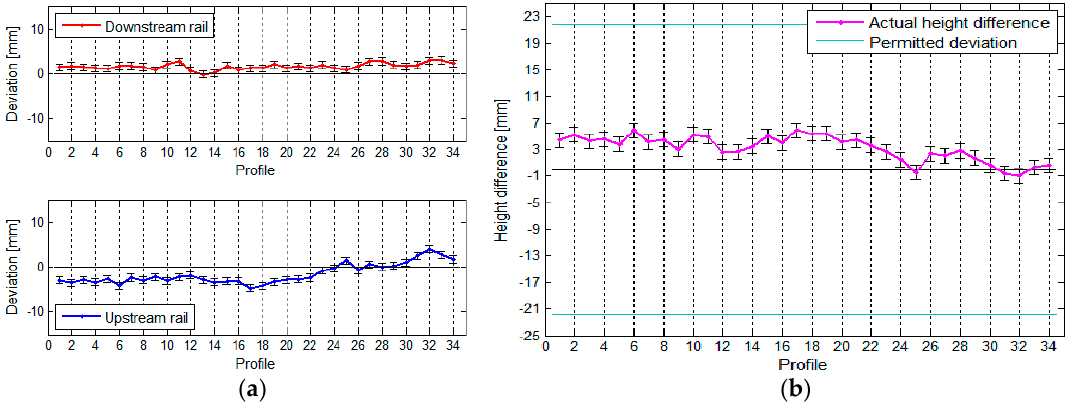
Figure 12. ( a ) The rails and their positional deviations, and ( b ) the span between the rails, with the standard deviations, for the crane in the HPP in Krško measured with TPS.